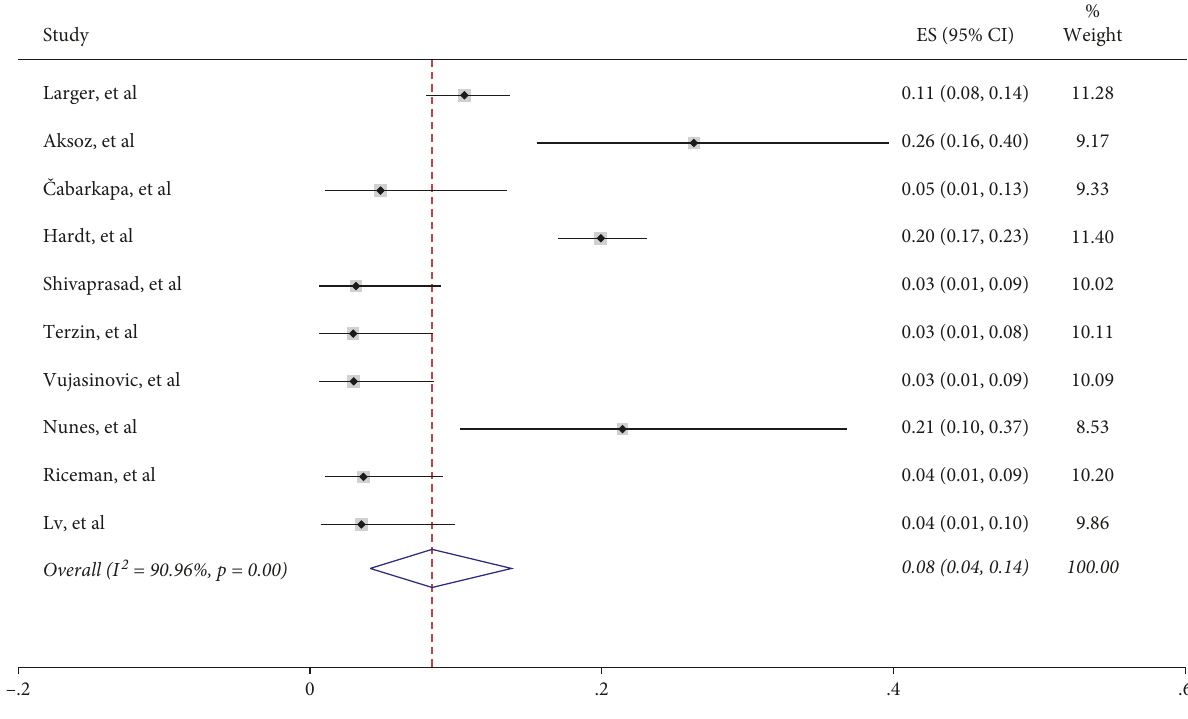
Figure 4: The prevalence of severe